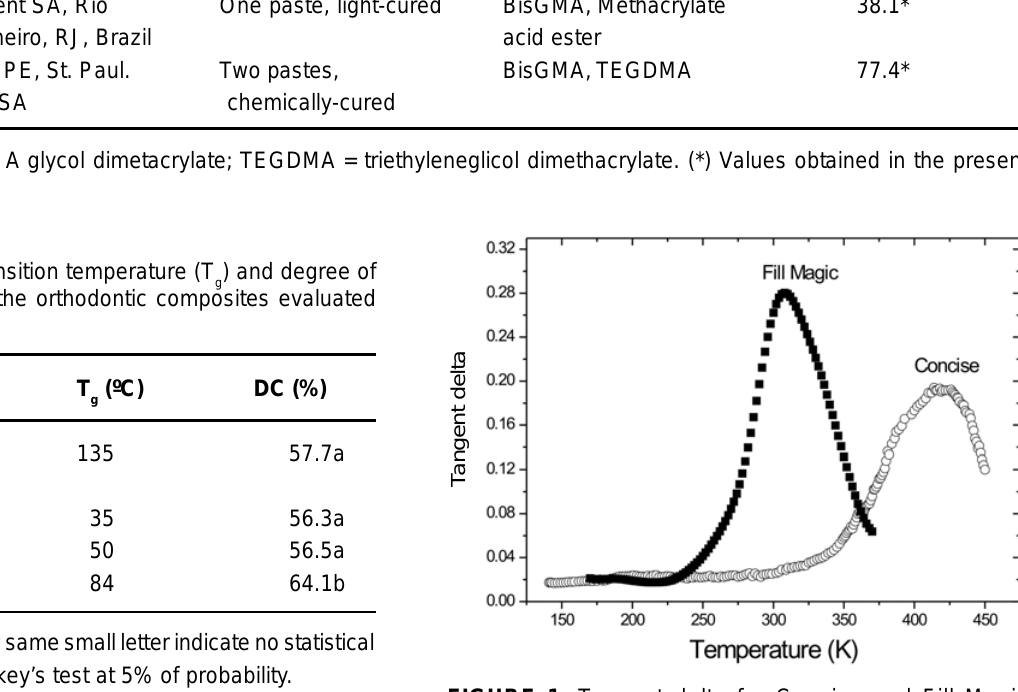
FIGURE 1- Tangent delta for Concise and Fill Magic